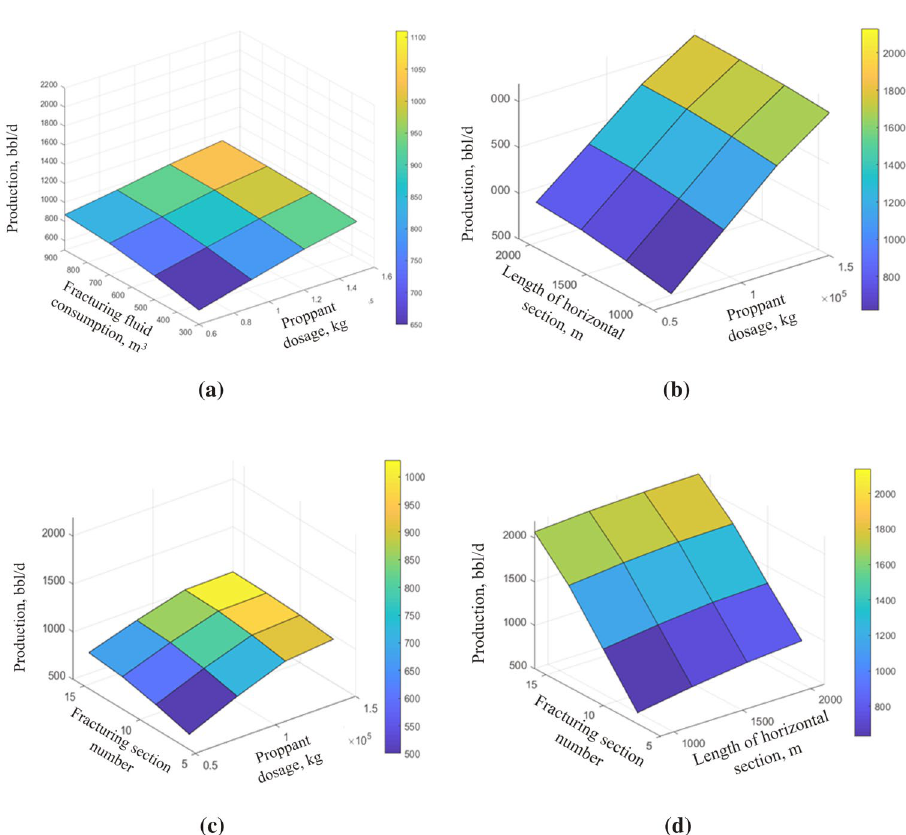
Fig. 24 Physical 2 + Engineer- ing 1 capacity